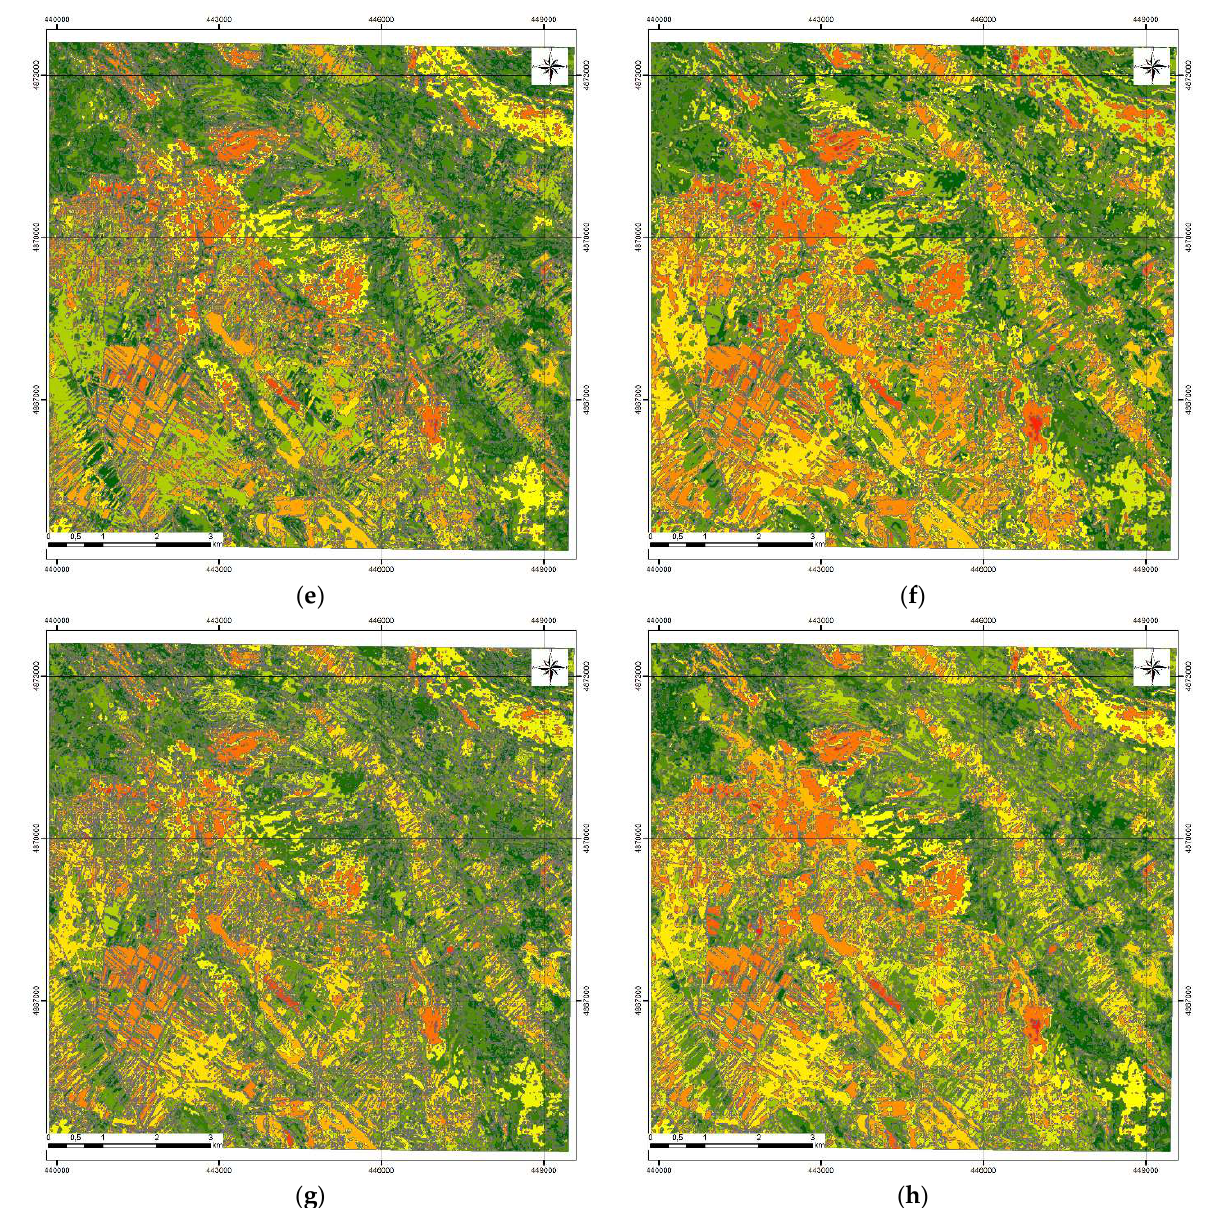
Figure 8. K-means classification results. All colors in each of the figures from a to h refer to a particular number of classes obtained by the K-means algorithm; ( a ) utilizes five classes and bands 2, 3, 4, 8 and 11; ( b ) utilizes five classes and all bands; ( c ) utilizes 10 classes and bands 2, 3, 4, 8 and 11; ( d ) utilizes 10 classes and all bands; ( e ) utilizes 15 classes and bands 2, 3, 4, 8 and 11; ( f ) utilizes 15 classes and all bands; ( g ) utilizes 20 classes and bands 2, 3, 4, 8 and 11; ( h ) utilizes 20 classes and all bands.